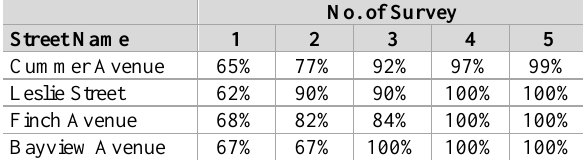
Table 4 . Accuracy detection rate after every data accumulation and